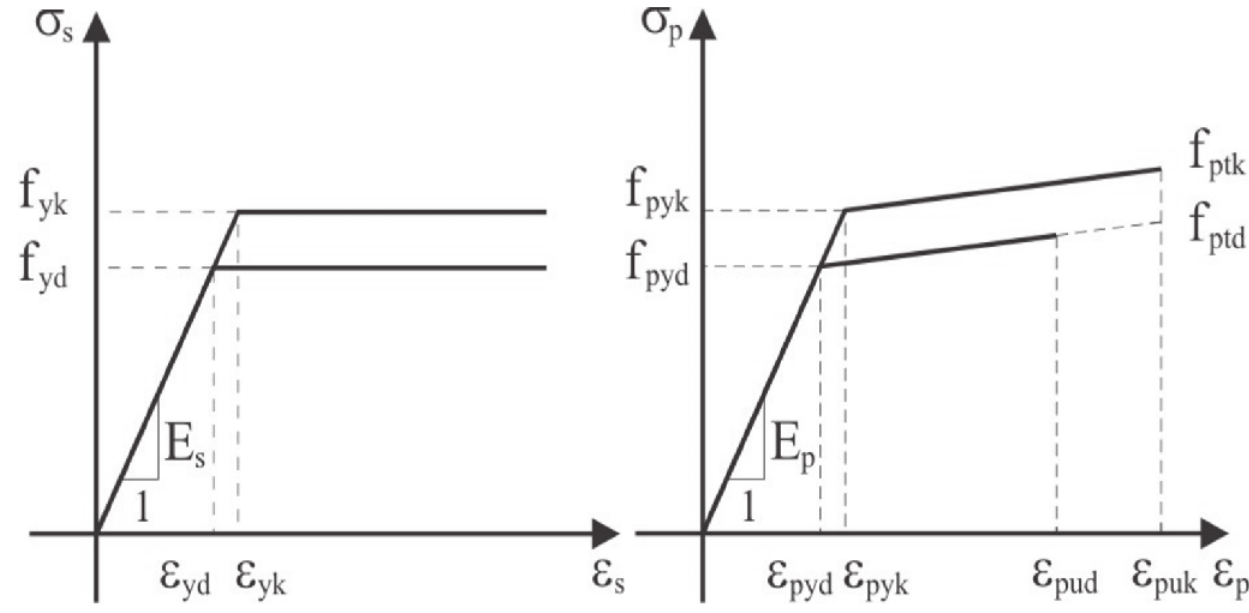
Stress-strain diagrams adopted for the passive and active reinforcements